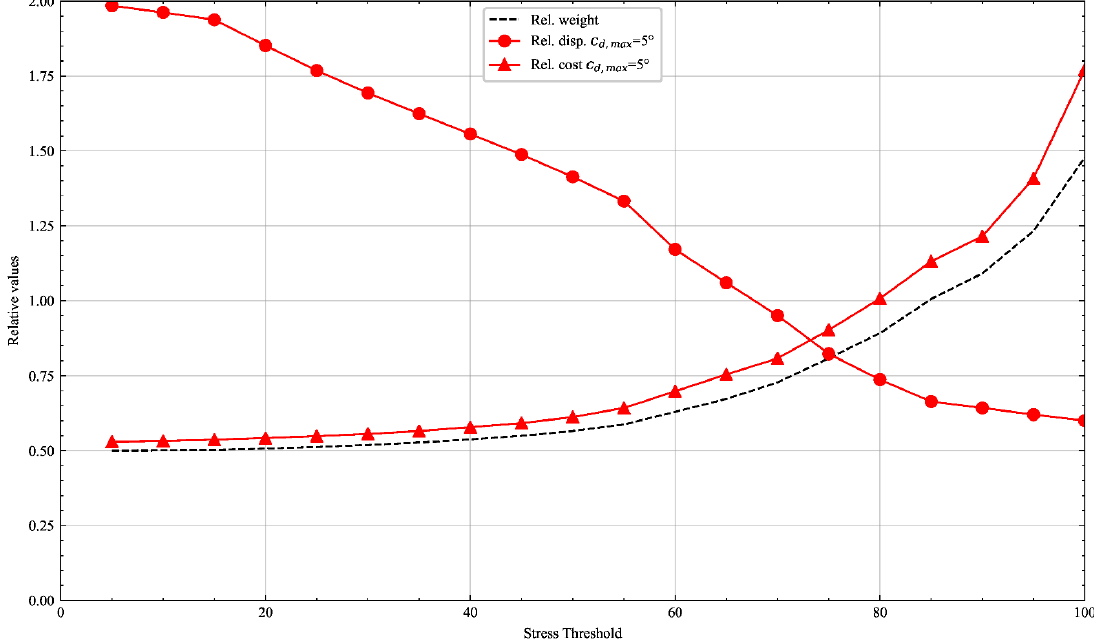
Figure 11. Results from both mechanical and economic models (c d,max = 5°) for the demonstration example introduced in Figure 8. Cost, displacement, and weight from the tailored textiles component are given as relative values in relation to the reference laminate.